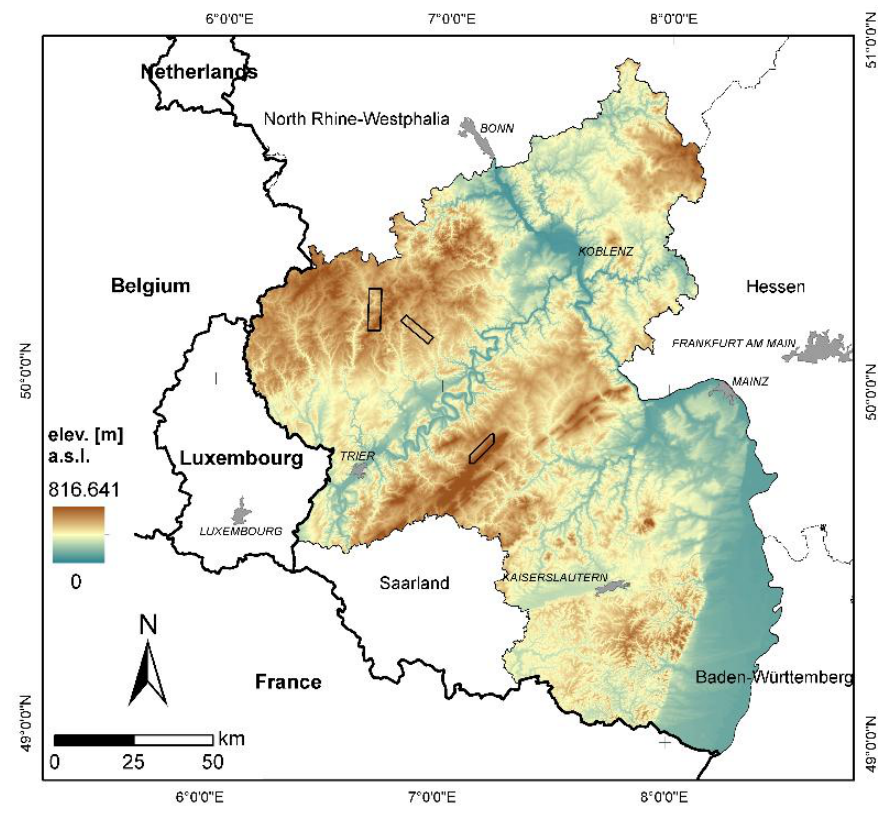
Figure 1. Study areas in the German federal state of Rhineland-Palatinate (black